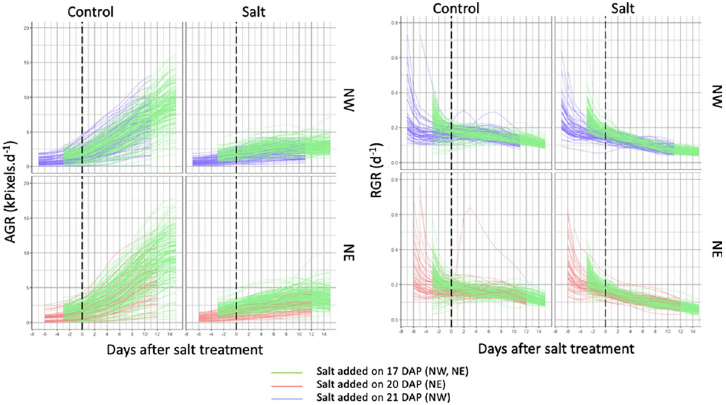
Fig 1. Plots of smoothed absolute growth rate and relative growth rates. Plots of absolute growth rate (AGR, right panels) and relative growth rate (RGR, left panels) smoothed by cubic splines for Northwest (NW, top panels) and Northeast (NE, bottom panels) Smarthouses. Different colors refer to different starting days of the salt treatment. Based on these plots, we decided to split the period of the experiment into the intervals: 1–4, 4–8, and 8–11 days after salt treatment. DAP refers to days after